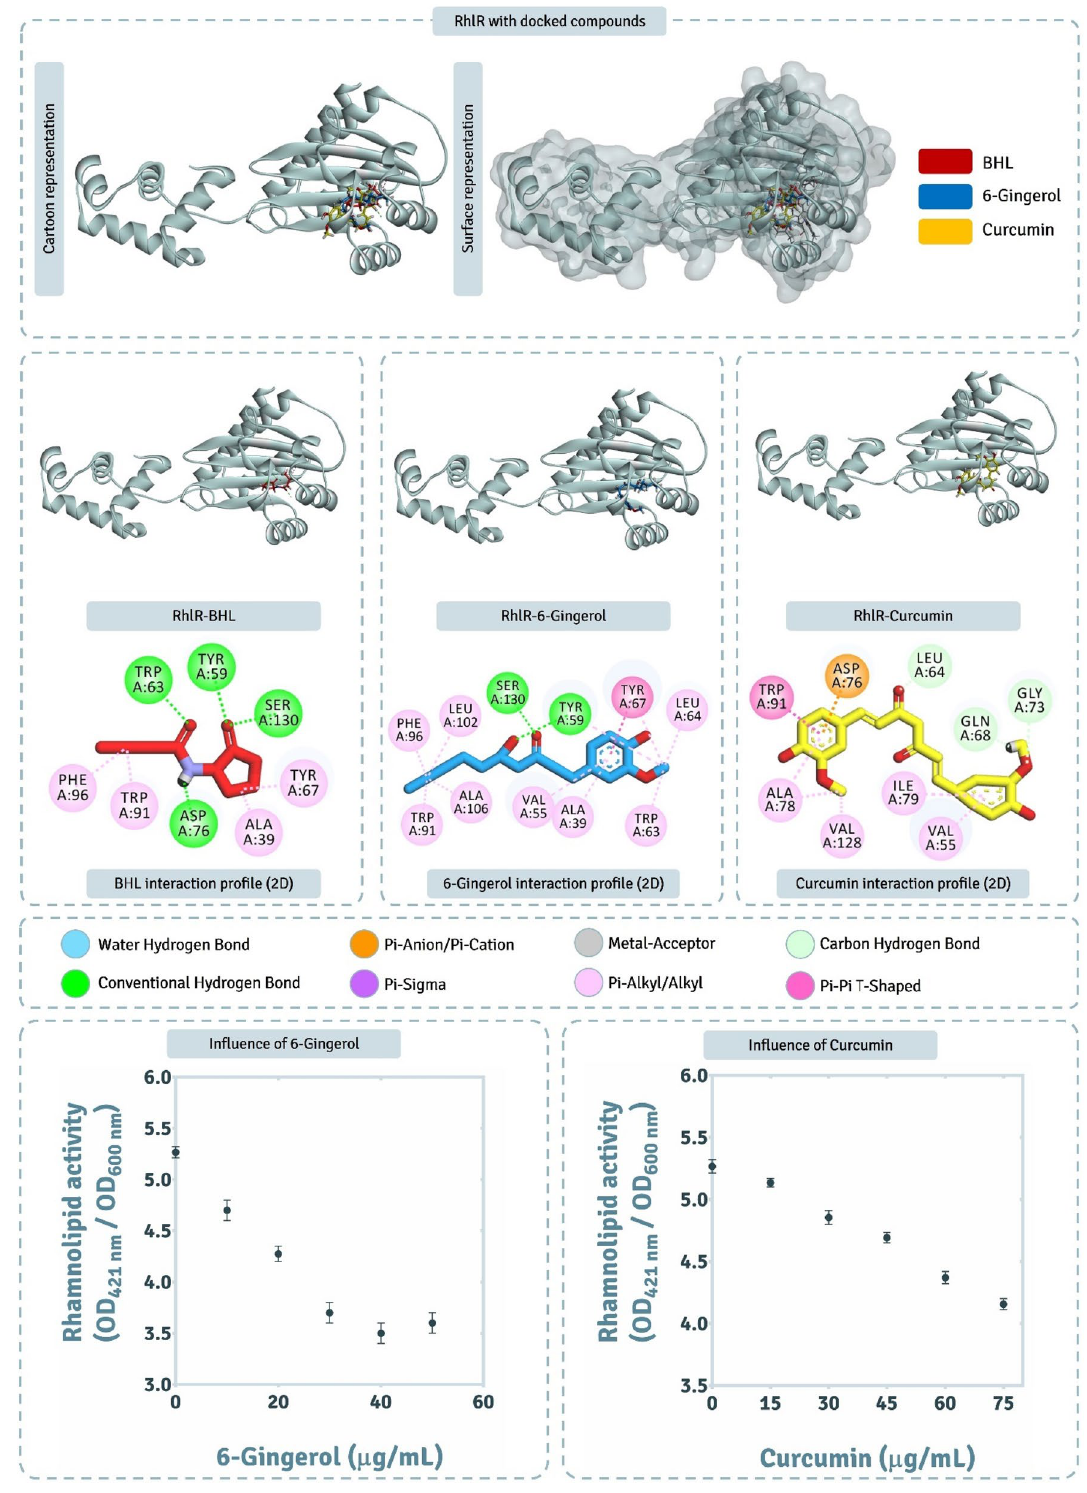
Figure 9. Interaction profile of RhlR with 6-Gingerol and Curcumin as predicted by XP docking and assessment of its QSA potential on rhamnolipid